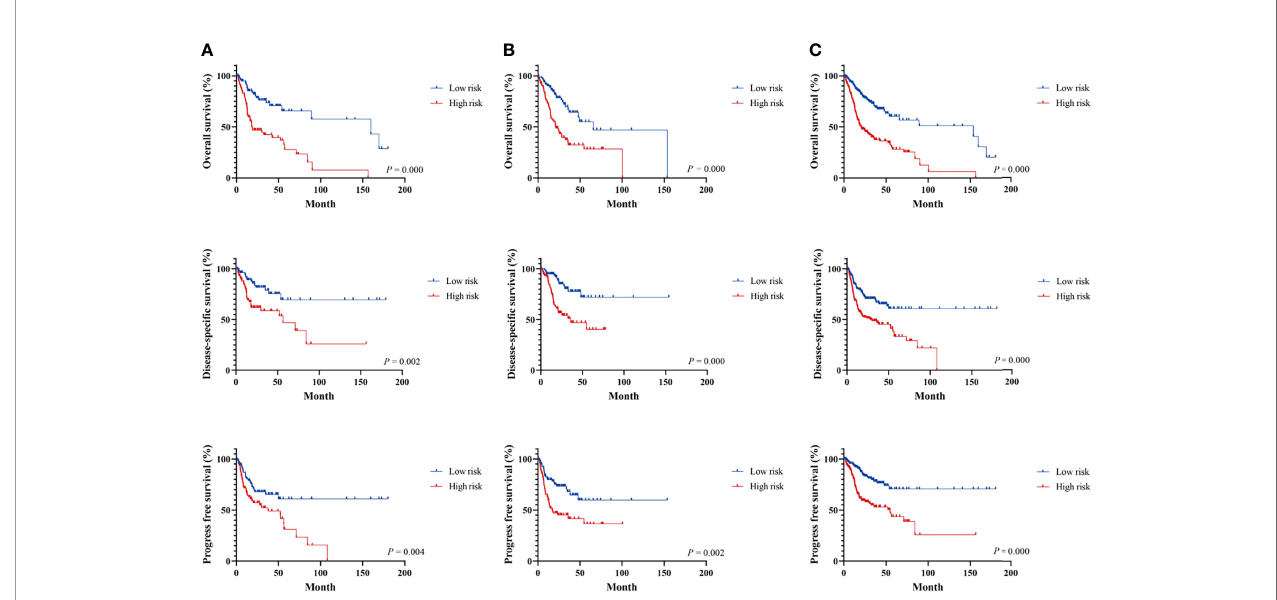
FIGURE 2 | Survival analysis of immune-related signature in the TCGA cohort. Kaplan – Meier curves for the survival rate of OSCC patients between the high-risk and low-risk groups in the training (A) , testing (B) , and whole TCGA set (C) , respectively. p -values for signi fi cance (<0.05) calculated using Cox regression